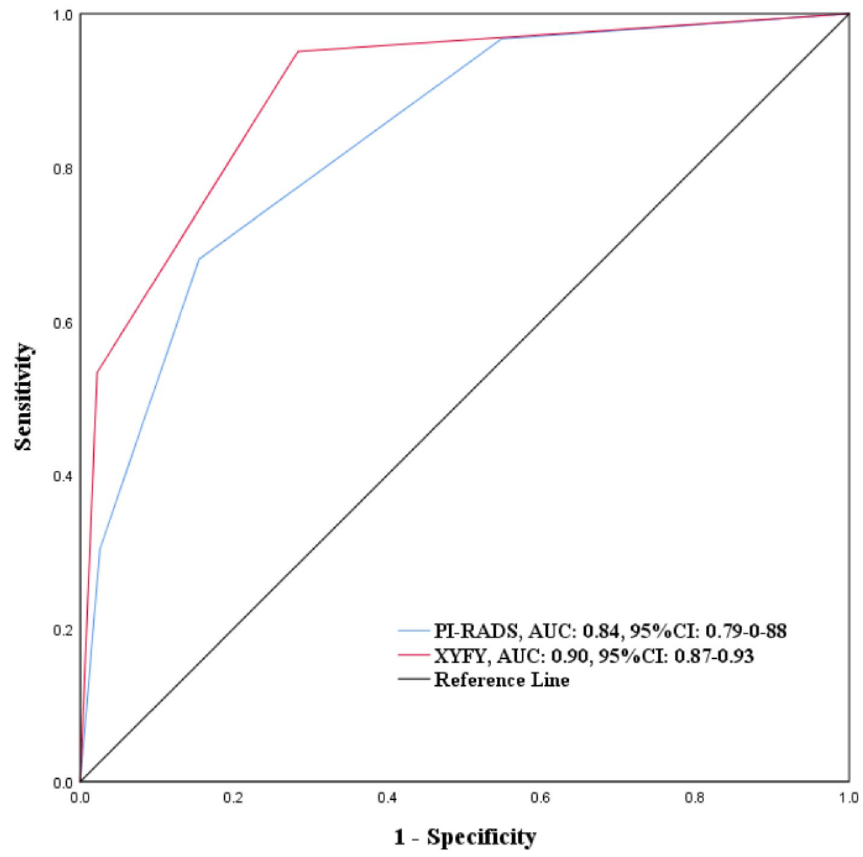
Figure 3. ROC curves for comparing predictive performance of XYFY risk model and PI-RADS. ROC receiver operating characteristic; PI-RADS Prostate Imaging Reporting and Data